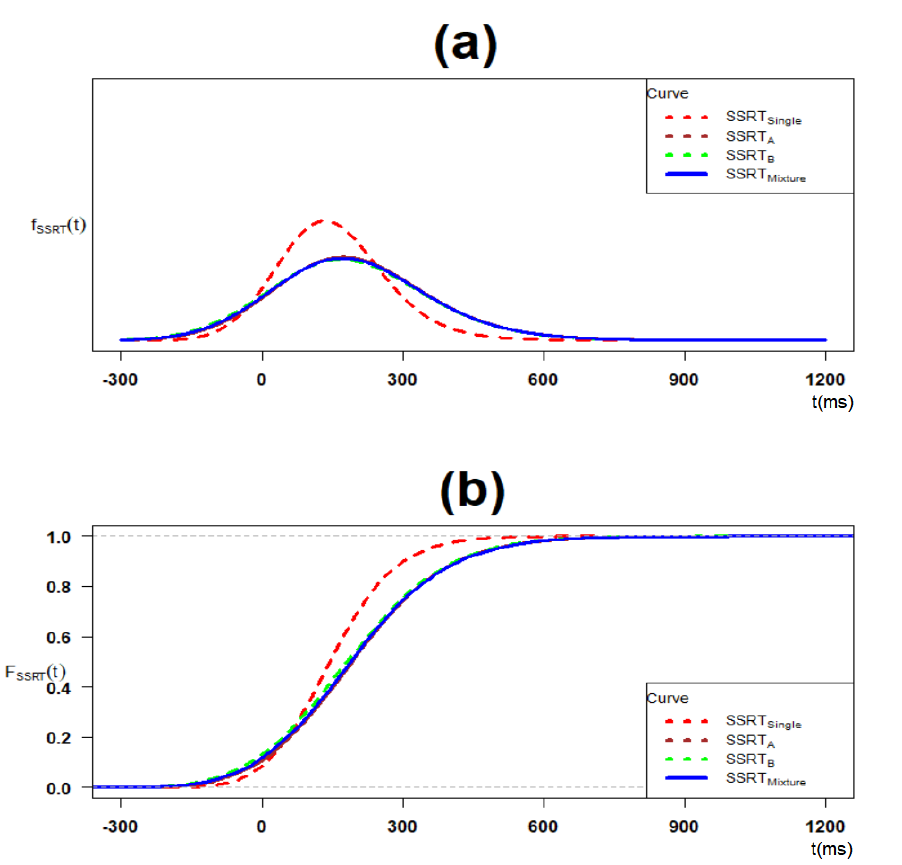
Figure 6. The density and cumulative distribution function (CDF) of overall sample cluster type SSRT, single SSRT and mixture SSRT with Ex-Gaussian parametric distribution: ( a ) density and ( b ) cumulative distribution